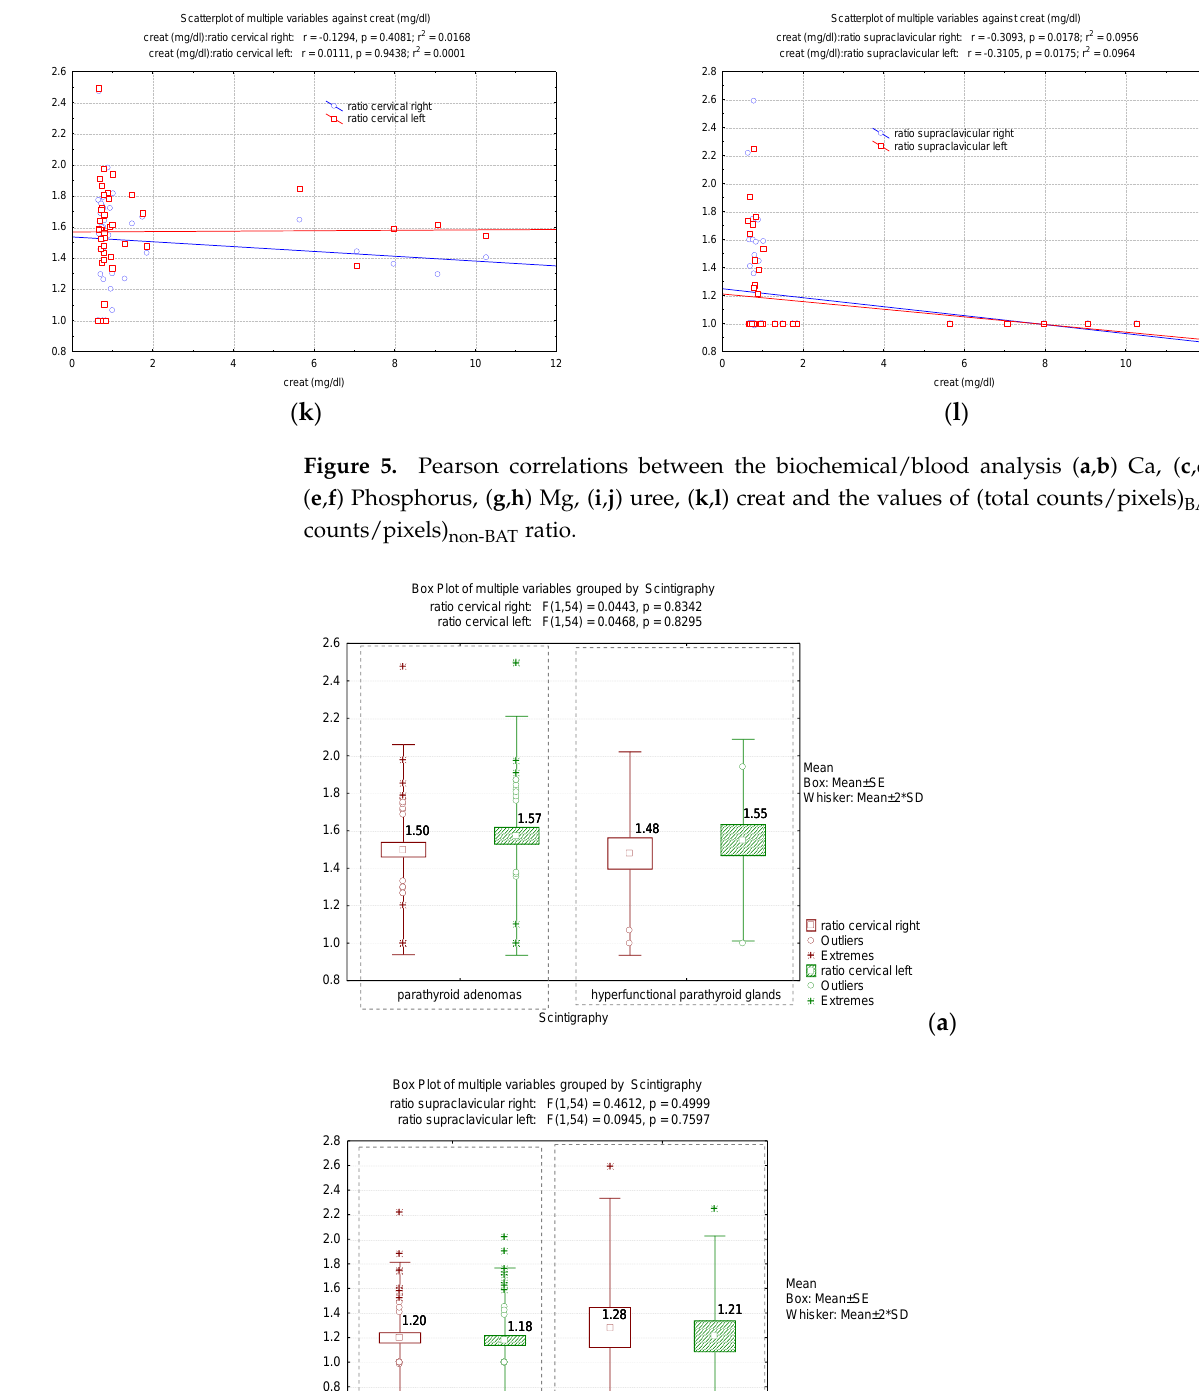
Box Plot of multiple variables grouped by Scintigraphy ratio supraclavicular right: F(1,54) = 0.4612, p = 0.4999 ratio supraclavicular left: F(1,54) = 0.0945, p = 0.7597